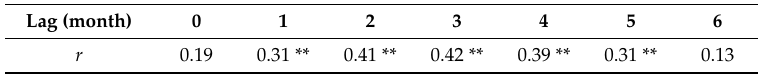
Table 3. Cross-correlations between the number of hemorrhagic fever with renal syndrome (HFRS) cases and the rodent population density.